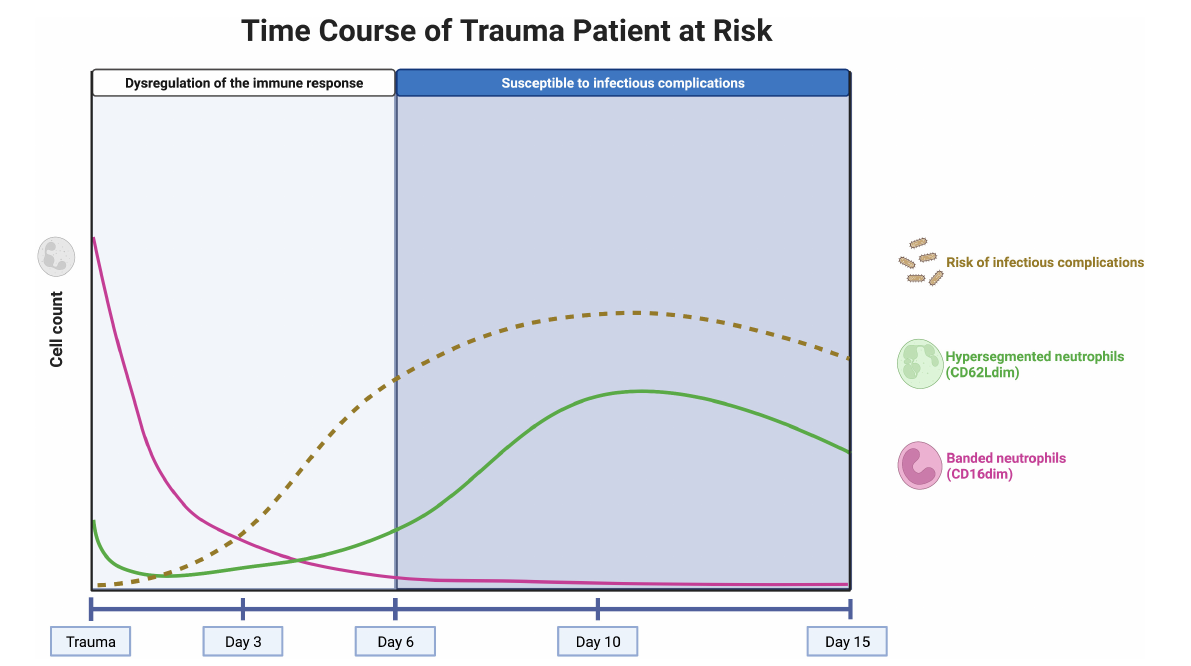
FIGURE1 Concept of the neutrophil subset response over time in a trauma patient at risk for infectious complications. The pink line represents the course of well-functioning banded (CD16 dim ) neutrophils, entering the circulation immediately after trauma. The influx of these cells stops after approximately 1 day and the neutrophils have an average lifetime of 5 days. The green line represents the course of hypersegmented (CD62L dim ) neutrophils, with impaired killing capacity. These cells appear after several days, with a peak after 10 days. The brown, dashed line represents the risk of infectious complications over time. The risk increases after 3–5 days, when there are no banded neutrophils left in the circulation. After 10 days, the peak of hypersegmented neutrophils coincides with the first systemic infectious complications. Created with